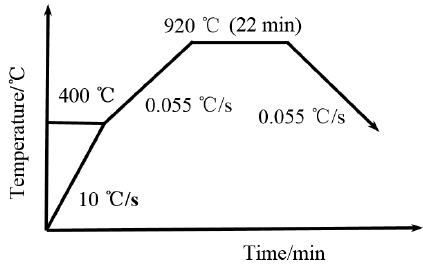
Figure 2. Heating process diagram.